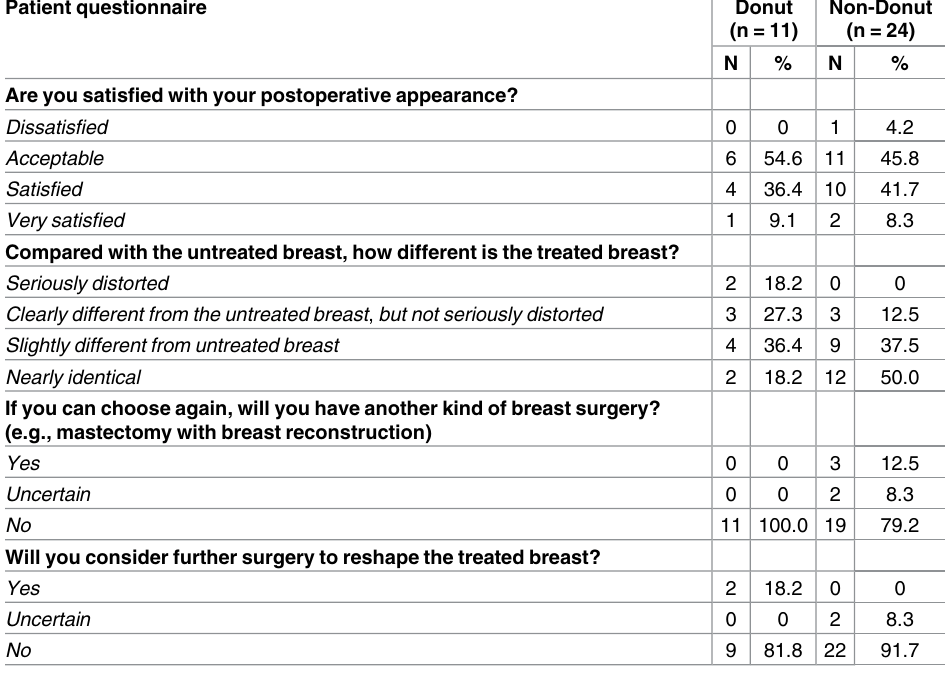
Table 2. Patient questionnaire results after oncoplastic breast-conserving surgery (n = 35; 1 patient was lost to follow-up). Patient